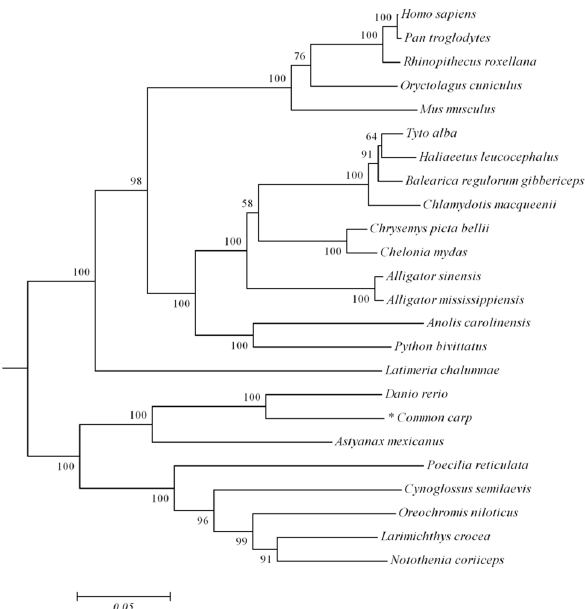
Figure 2. Phylogenetic analysis of TRIM32. Neighbor-joining tree was constructed with MEGA5.1, branches indicate confidence level of 10,000 bootstrap replications. All of the accession numbers used in this analysis are as follows: Pan troglodytes : XM_016961541.1; Rhinopithecus roxellana : XM_010381004.1; Oryctolagus